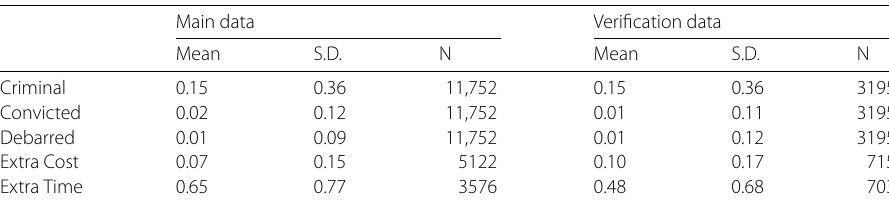
Table 3 Summary statistics: outcomes Main